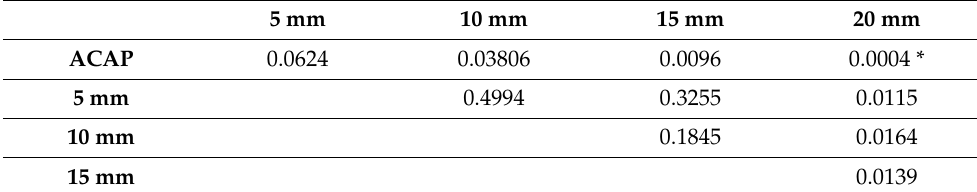
Table 4. Post-hoc test p -values (under